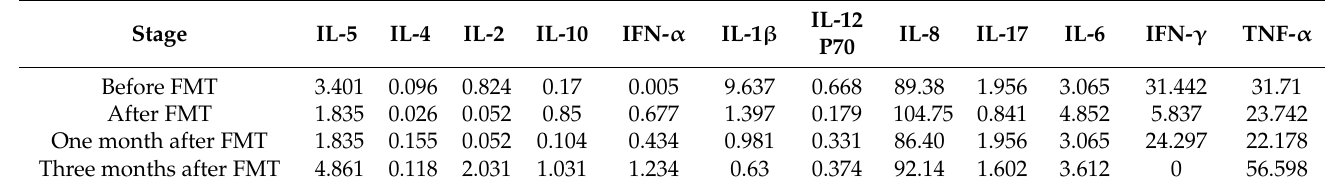
Table 3. Cytokine changes before and after FMT (pg/mL).